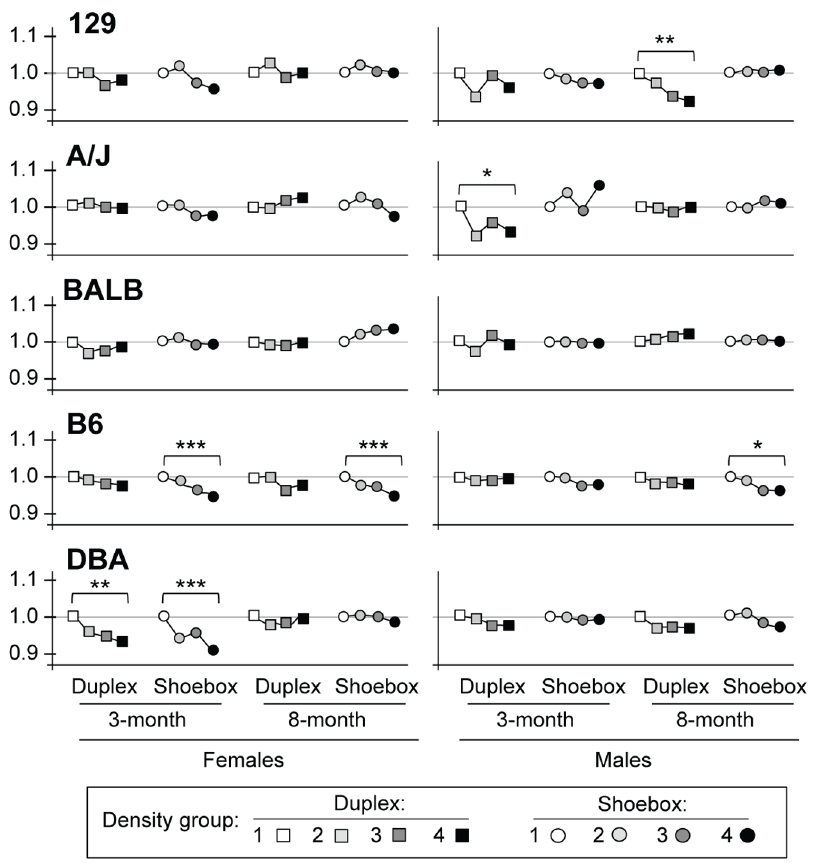
Figure 4. Heart weight. N=16–18 animals per sex/strain. The lowest density is given a value of 1.0 and all other densities are relative to that. Mean values and SEM are shown in Tables S2 and S3). P -values are comparisons of Density group 1 vs. Density group 4 only: * P , 0.05; ** P , 0.01; *** P , 0.005.